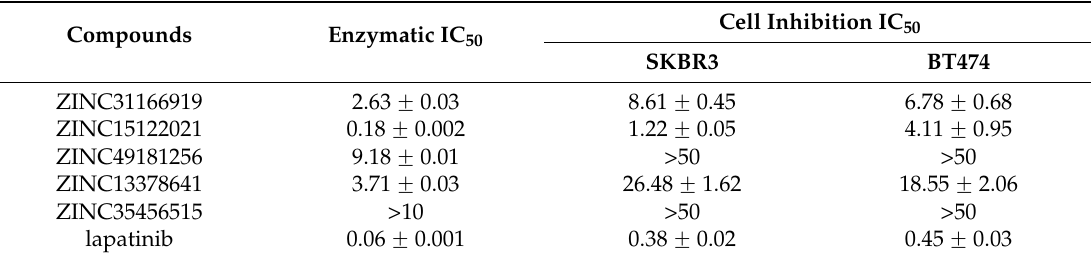
Figure 5. Cell viability of normal breast cells treated with three potential HER2 inhibitors by using CCK-8 assay. Error bars correspond to standard deviations from three independent measurements.